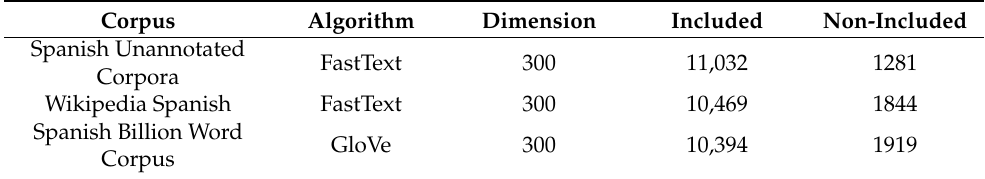
Table 1. Analysis of the number of words included in word embeddings. Corpus